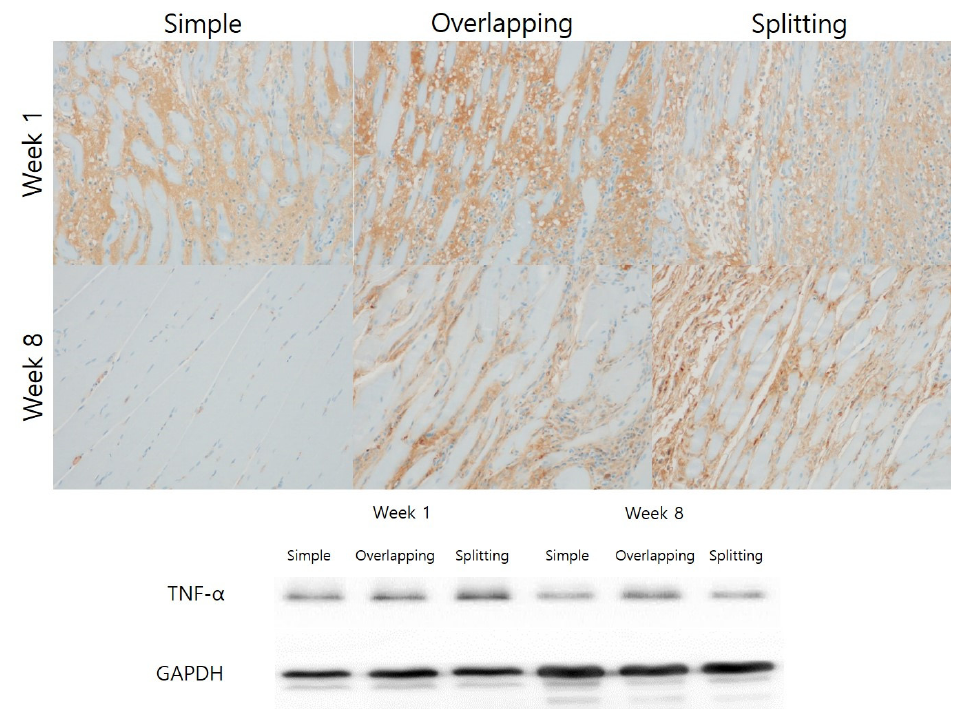
Figure 7. Immunohistochemical and Western blot analysis of IL-1 expression. At week 1, all groups showed strong expression of IL-1 by immunohistochemistry and Western blotting. The simple in- terrupted suture group exhibited weaker expression of IL-1 than the overlapping and splitting su- ture groups by immunohistochemistry and Western blotting.